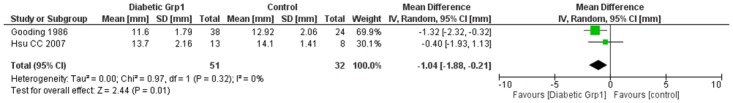
Meta-analysis and forest plot for sub-metatarsal head 1 unloaded total soft tissue depth, non-diabetic and diabetic group 1.